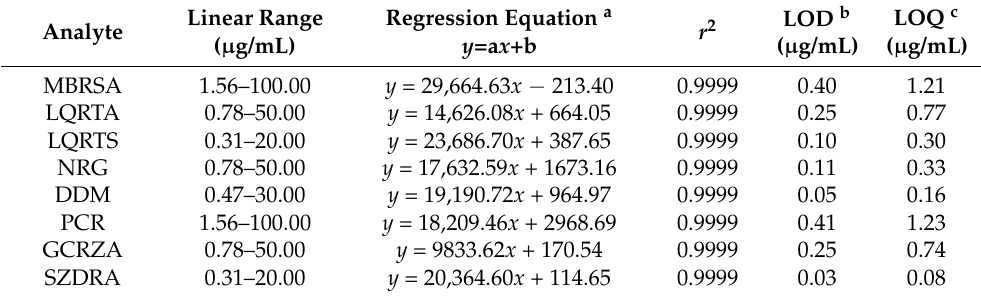
Table 1. Linear range, regression equation, coefficient of determination ( r 2 ), limits of detection (LOD), and quantification (LOQ) for the simultaneous analysis of eight authentic standards by HPLC ( n = 3).